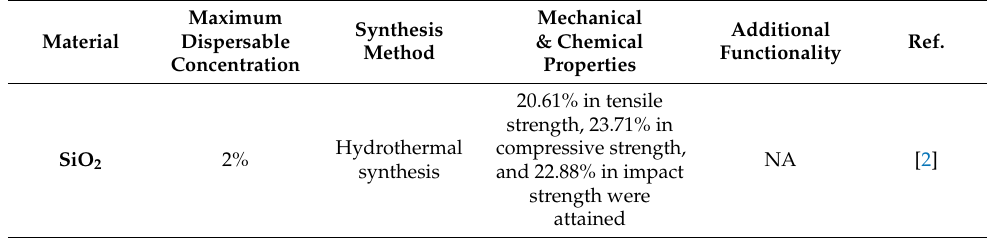
Table 1. Comparison of proposed work with previously reported nano-fillers.